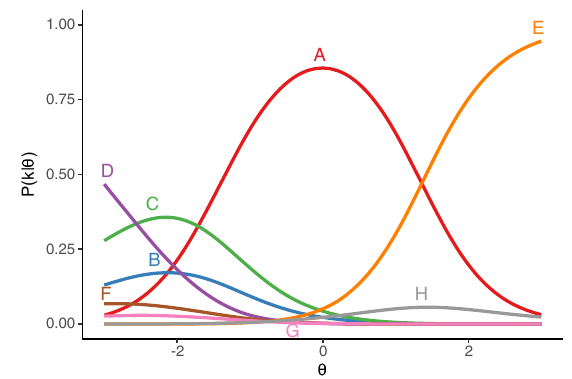
FIG. 1. IRT category characteristic curves showing the prob- ability of selecting a particular response for item 14 of the FMCE, given a students ’ latent trait θ . Curves were generated from ; d Eq. (3) using the f a parameters from Table k; 14 k; 14 g